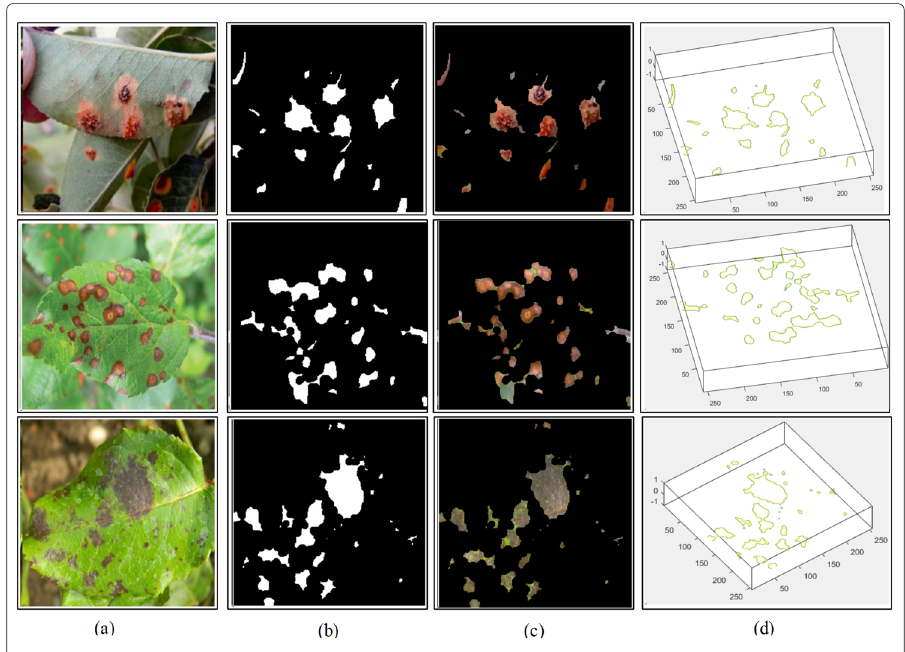
Fig. 11 Proposed segmentation results. a Original image. b Segmented image. c Infection part mapped on the original image. d Contour of the infection